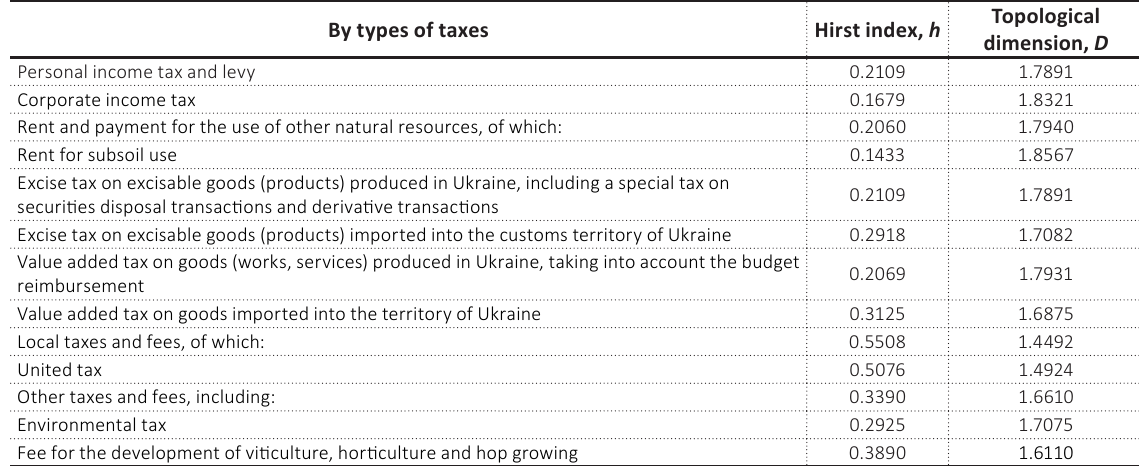
Table 1. Results of R|S-analysis of the dynamics of tax revenues to the Consolidated Budget of Ukraine for the period January 2011–May